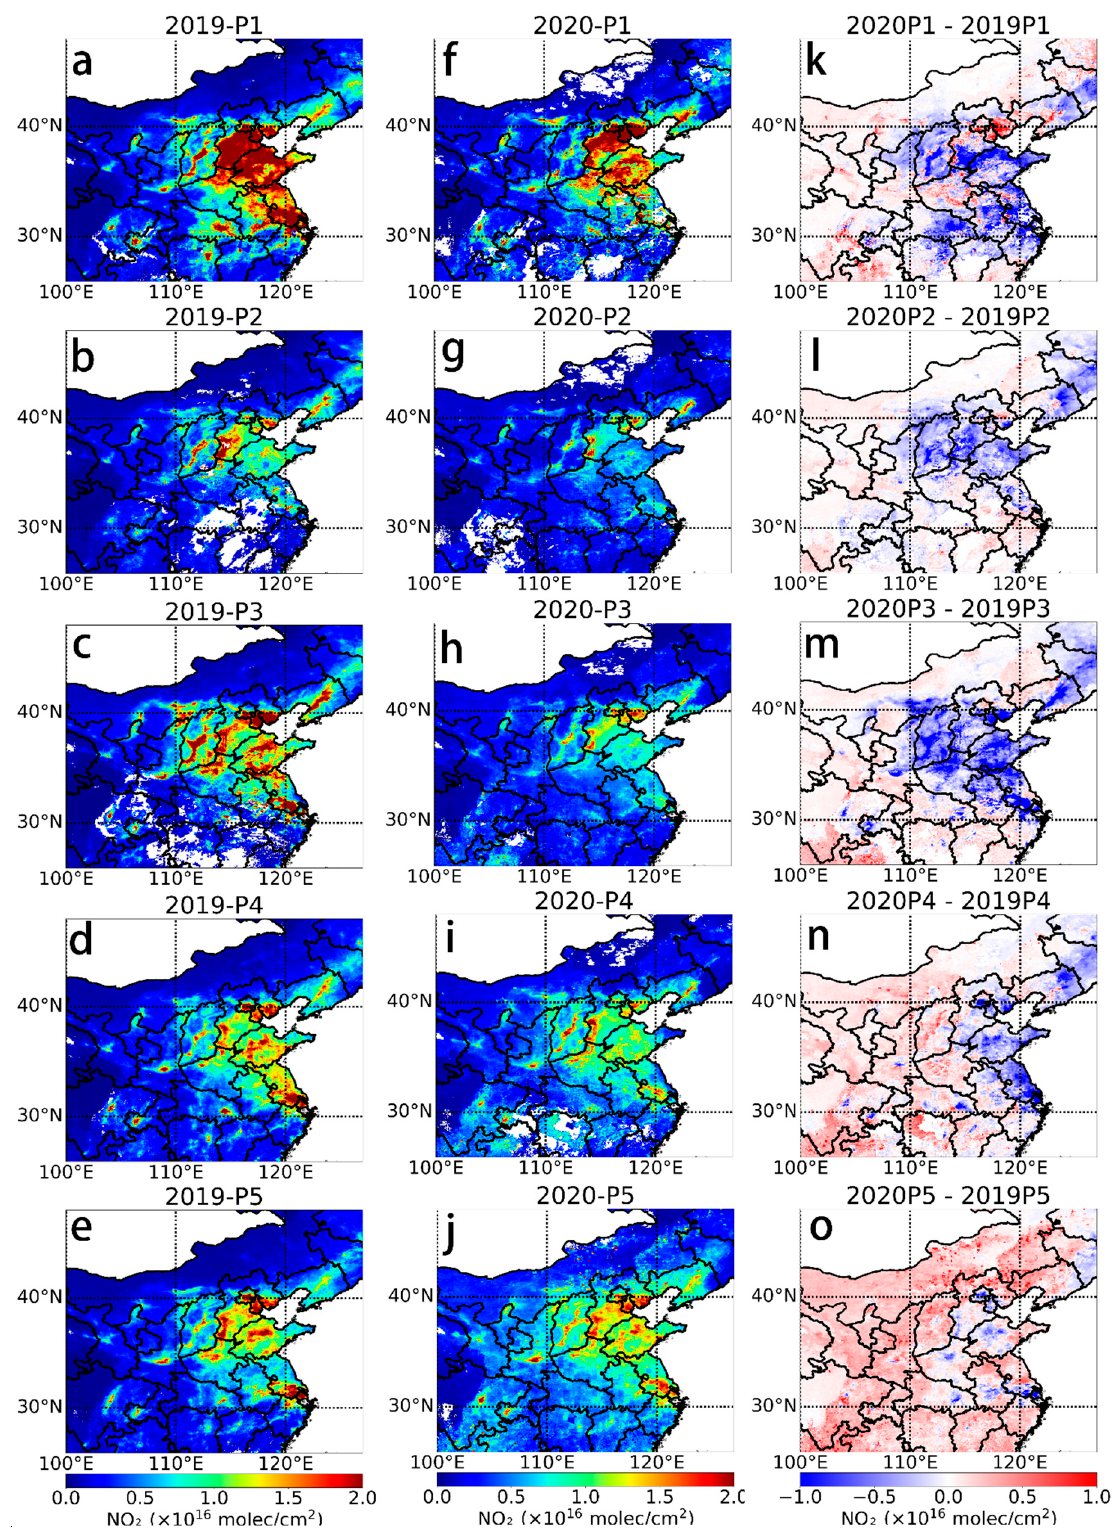
Figure 6. Comparison of the distribution of the NO 2 TVCD for the same period (15-day average) in 2020 and 2019 in the Chinese region. ( a – e ) P1-P5 in 2019, ( f – j ) P1-P5 in 2020, ( k – o ) P1-P5 differences between 2020 and 2019.